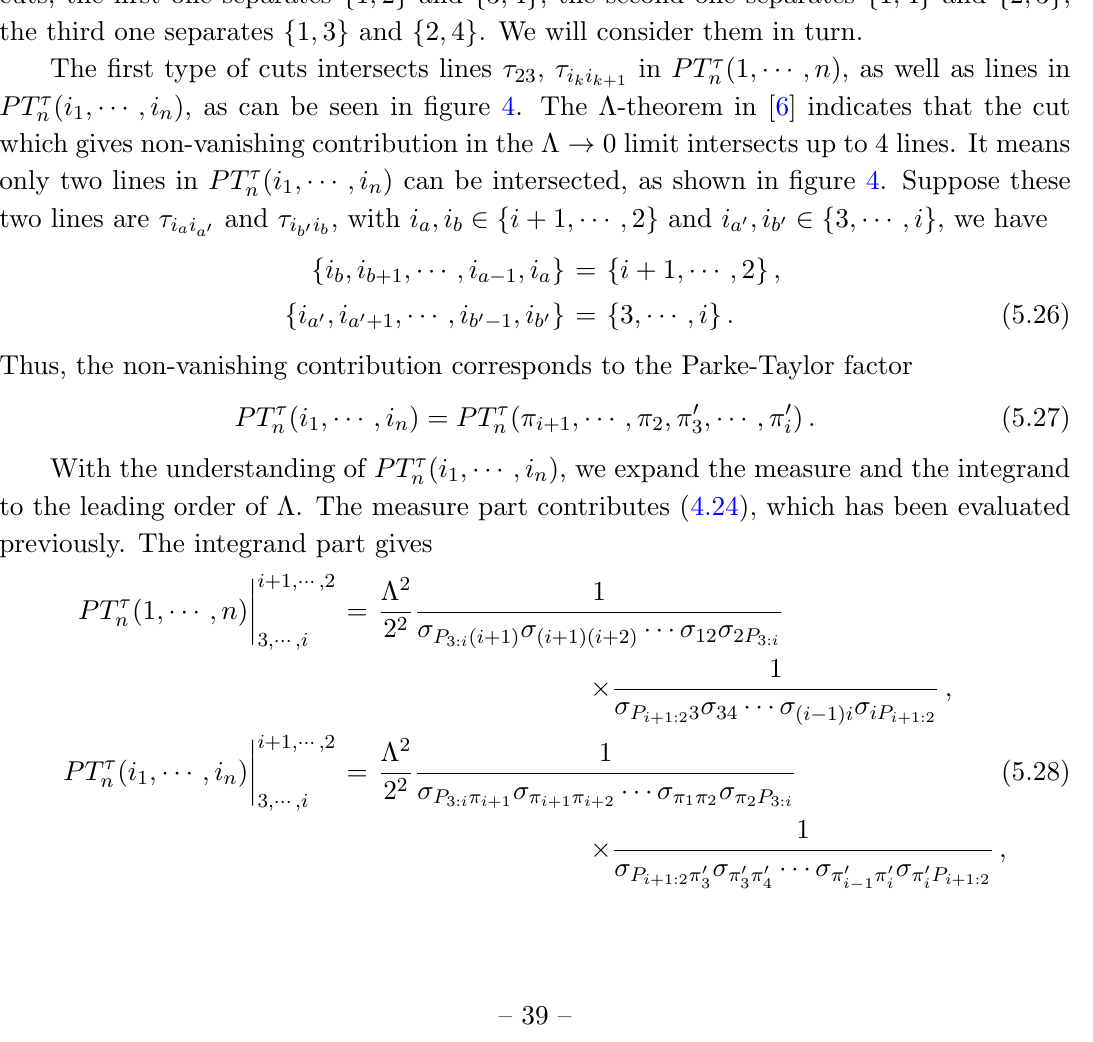
(1 ; (cid:1) (cid:1) (cid:1) ; n n